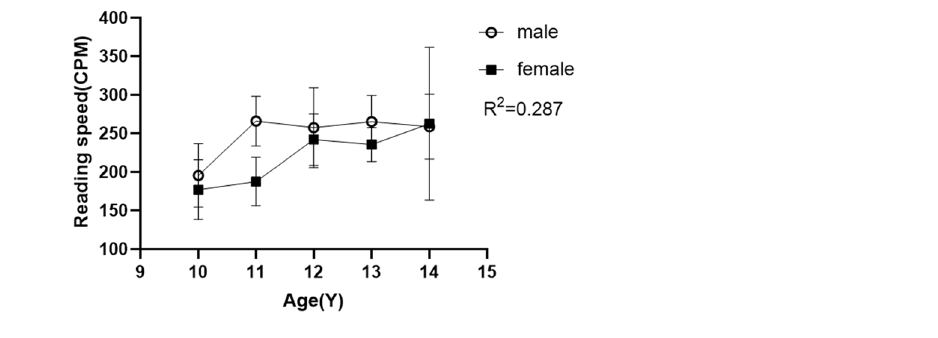
Figure 2. Comparison of reading speed between male and female in IXT. CPM character per minute, Y year. Age factor: F = 6.29, p = 0.001 (***); Gender factor: F = 6.69, p < 0.017 (**). R 2 = 0.287, the effect of age and gender on reading speed of IXT was only